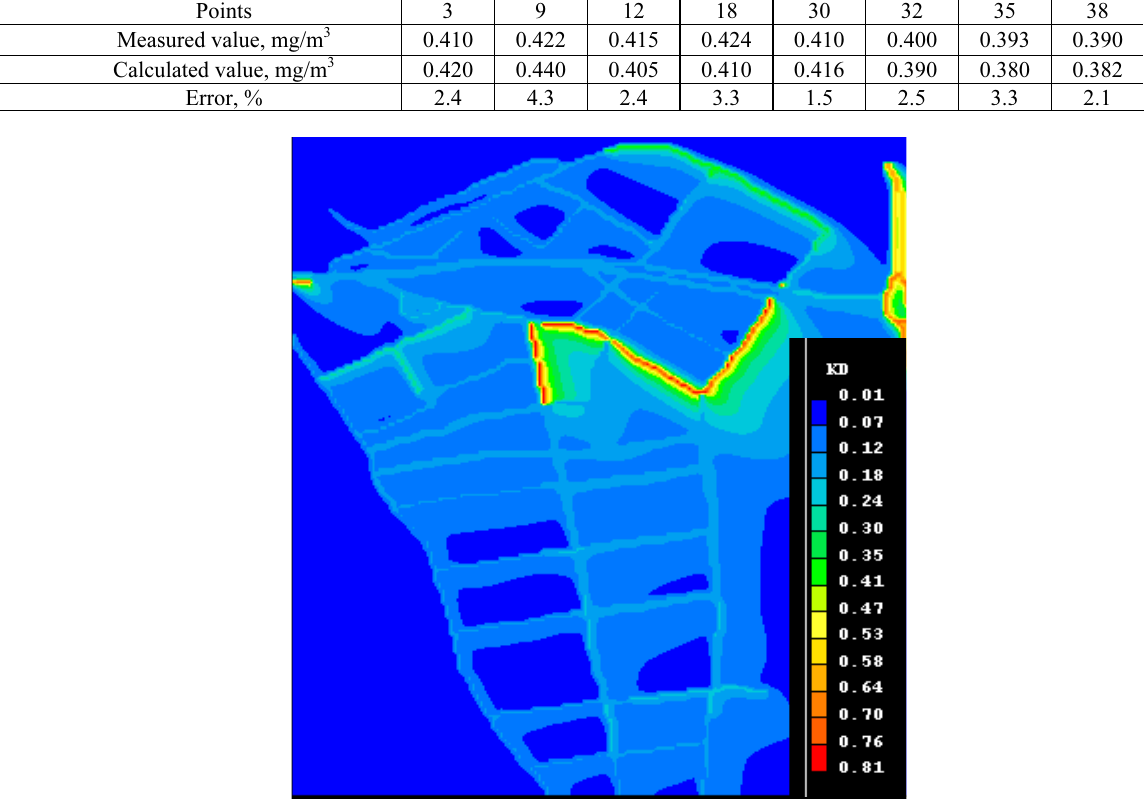
Fig. 4. Results of SP concentration dispersion on January 30, 2006 (“rush” hours) in Žvėrynas district area Table 4. Comparison of experimental results (of January 30, 2006 during “rush” hours) and theoretically calculated